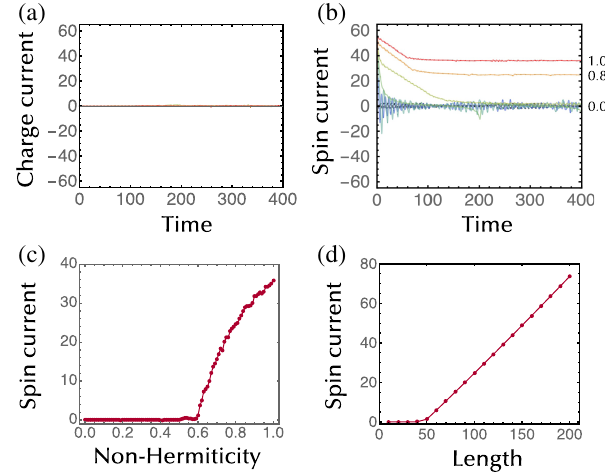
FIG. 10. Current in the symplectic Hatano-Nelson model with open boundaries ( J ¼ 1 . 0 , Δ ¼ 0 . 5 ). The initial state is prepared as Eq. (24). Time evolution of the (a) charge current I c ð t Þ ≔ ˆ I ψ ð t Þi and (b) spin current I t Þ ≔ h ψ ð t Þj ˆ I ψ ð t Þi for h ψ ð t Þj c j s ð s j L ¼ 100 and γ ¼ 0 . 0 , 0.2, 0.4, 0.5, 0.6, 0.8, 1.0. (c) Spin current for the steady state as a function of non-Hermiticity γ for L ¼ 100 . (d) Spin current for the steady state as a function of the system length L for γ ¼ 0 . 8